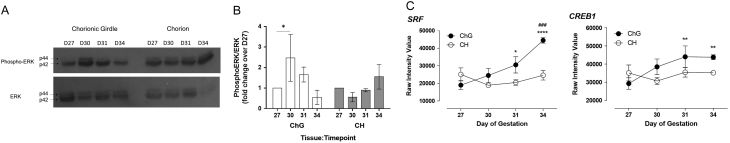
Activity of the ERK1/2 pathway in the chorionic girdle. (A) Representative western (n = 3) for phospho-ERK and total ERK in one timecourse set of chorionic girdle and chorion tissues. Shown are the phosphorylated and total p44 (ERK2) and p42 (ERK1) protein. (B) Densitometry analysis of western blots for phospho/Total ERK (P44/42) n = 3. *P < 0.05. (C) Multiplex qRT-PCR was used to quantify mRNA expression of SRF and CREB1. *P < 0.05, **P < 0.01, ****P < 0.0001 (compared to day 27 chorionic girdle), ###P < 0.001 (compared to chorion at same timepoint) (two-way ANOVA).